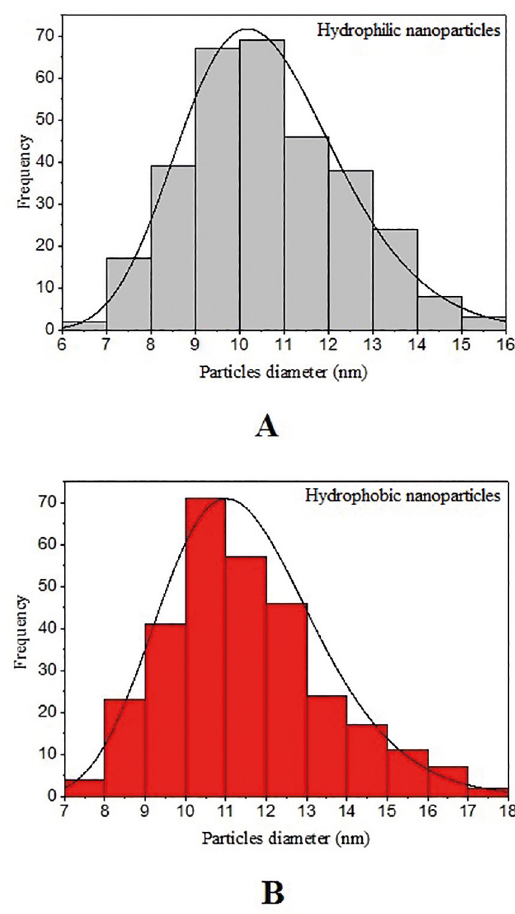
Figure 2. Size distribution histogram of the hydrophilic nanoparticles (A) and the hydrophobic nanoparticles (B).